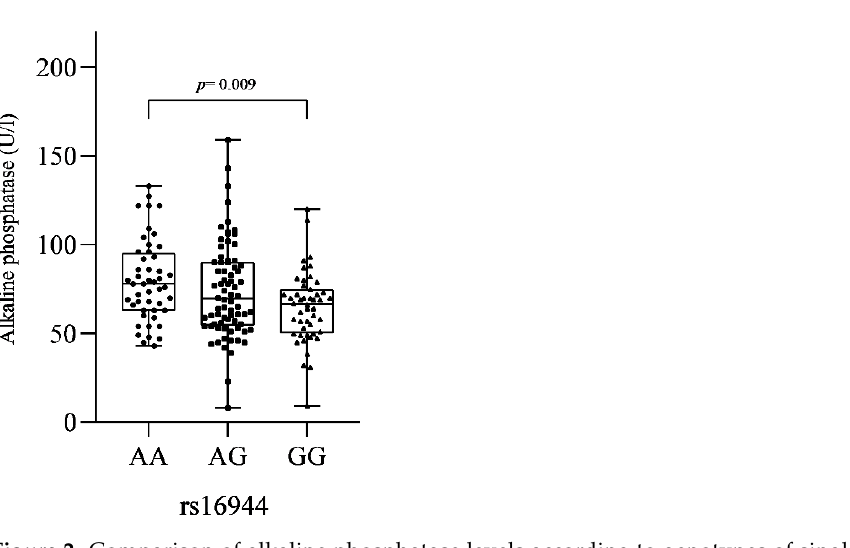
Figure 3. Comparison of biochemical markers of bone homeostasis in serum according to genotypes of single ‐ nucleotide variants rs1946519 of IL ‐ 18 and rs1644 of IL ‐ 1 β gene. ( a ) Comparison of 25(OH) Vitamin D levels between genotypes of rs1946519 of IL ‐ 18. ( b ) Comparison of Alkaline phosphatase levels between genotypes of rs16944 of IL ‐ 1 β . Statistical tests values: ( a ) p ‐ value ANOVA = 0.029; p ‐ value Tukey = 0.018 (AA vs. AC); ( b ) p ‐ value ANOVA/Kruskall–Wallis = 0.023; p ‐ value Dunn’s test = 0.026 (AA vs. GG). To summarize our results, despite the lack of association between the inflammasome genes’ SNVs and OP occurrence, a statistically significant correlation between genotypes and BMD levels was observed for SNVs rs35829419 CA of NLRP3 and rs16944 GG of IL ‐ 1 β gene. Furthermore, lower PTH serum level was associated with the variant rs16944 GG in IL ‐ 1 β gene, and lower vitamin D levels associated with IL ‐ 18 rs1946519 AA patients.